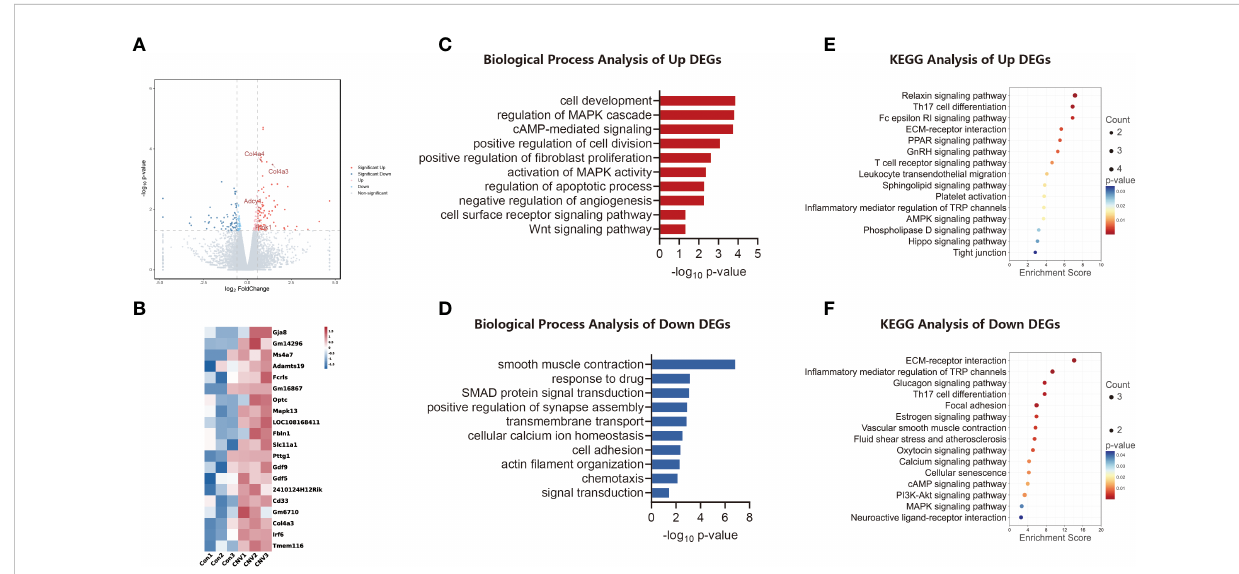
FIGURE 1 Transcriptomic analysis of the CNV mouse retina. (A) Volcano plot visualizing transcriptomic alterations, where red dots represent signi fi cantly upregulated genes, green dots represent signi fi cantly downregulated genes, and some red dots are labeled to illustrate high regulation. (B) Heatmap of the top 20 differentially expressed genes (DEGs) between CNV and control retinas. (C) Bar chart of sectional biology progress (BP) gene ontology (GO) terms of upregulated DEGs. (D) Bar chart of sectional biology progress (BP) gene ontology (GO) terms of downregulated DEGs. (E) Bubble plot of partial enriched Kyoto Encyclopedia of Genes and Genomes (KEGG) pathway terms of upregulated DEGs. (F) Bubble plot of partial enriched KEGG pathway terms of downregulated